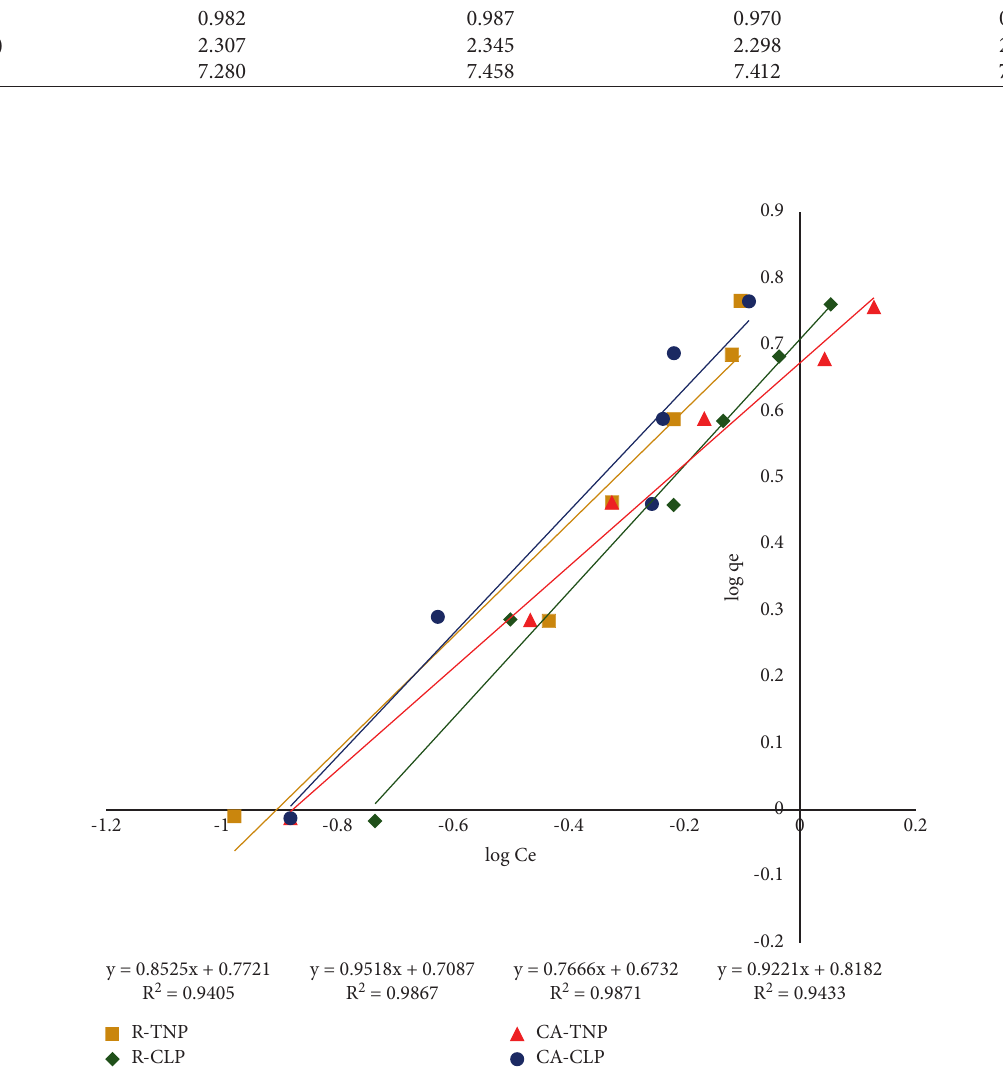
Figure 13: Comparison of effective parameters of Freundlich isotherm for the adsorption of BGD. Adsorbent dose � 0.5g, contact time � 25min, temperature � 30 ° C, agitation speed � 100rpm, initial pH � 5, final pH: R-TNP � 5, R-CLP � 4.5, CA-TNP � 4.0, and CA- CLP � 4.0, and dye solution volume V � 100